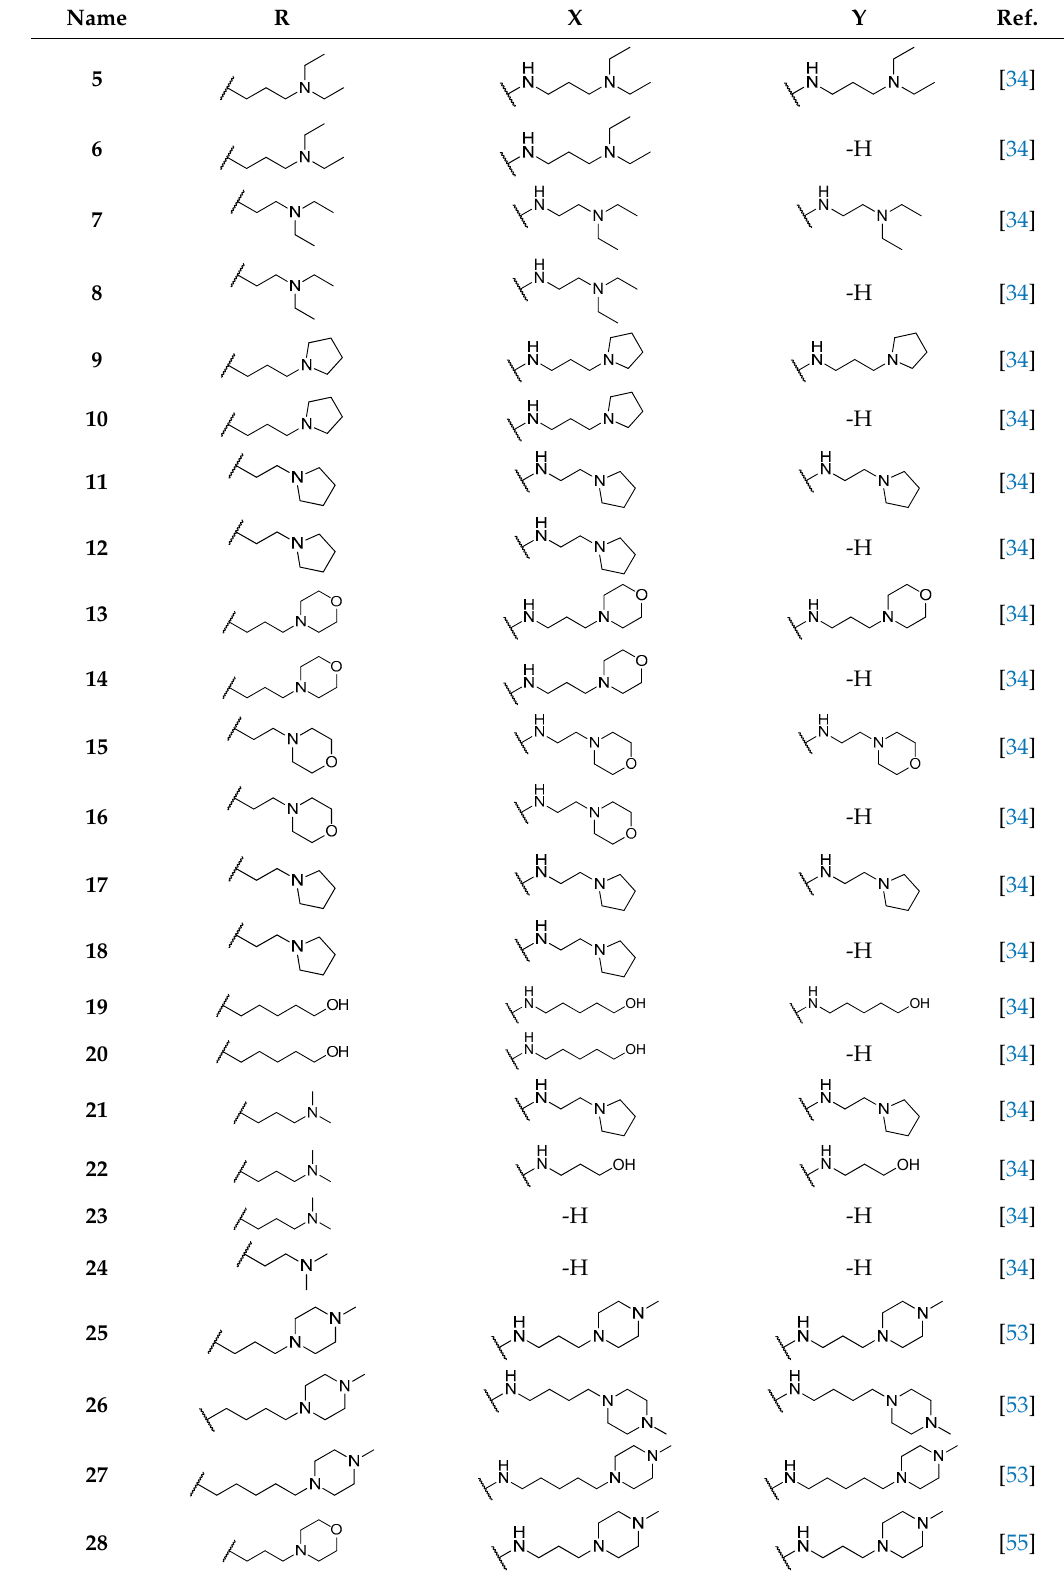
Table 1. Structures of NDIs used as reversible ligands to stabilize telomeric G4s.